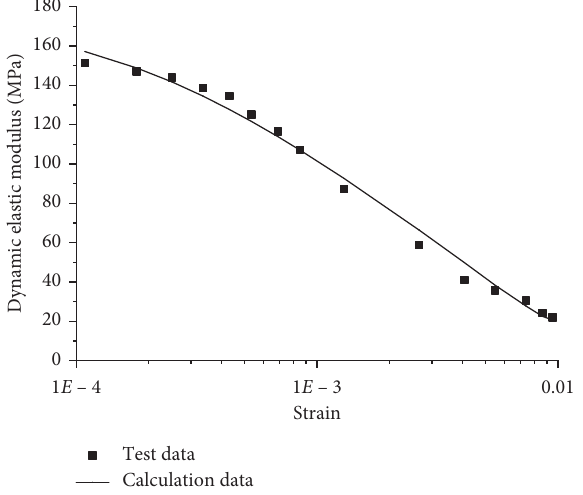
Figure 15: The relationship between E